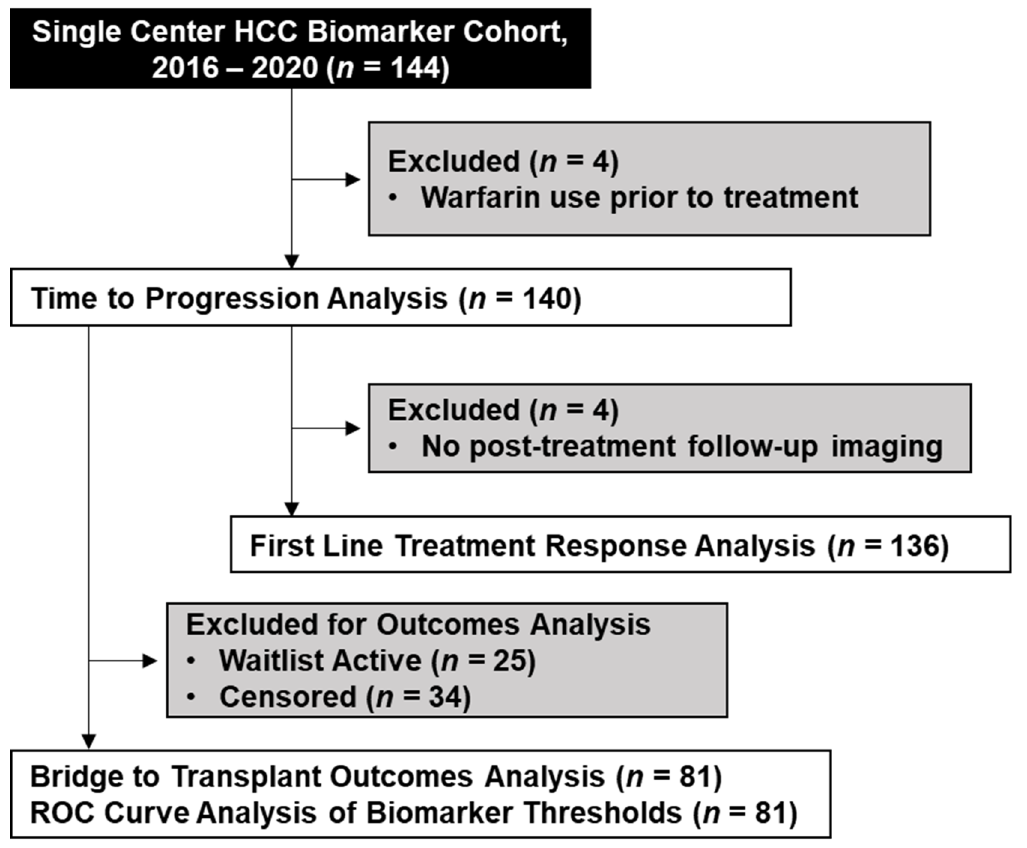
Figure 1. CONSORT Diagram of the Study Cohort. Outline of a single center retrospective analysis of prospectively collected data to assess time to progression and outcomes associated with expression of the AFP, AFP-L3, and DCP biomarkers.